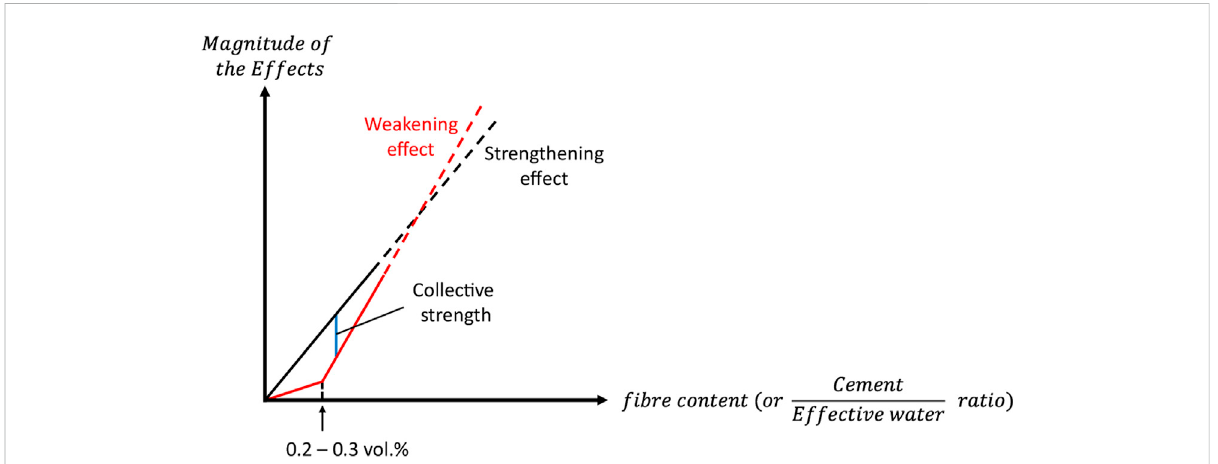
FIGURE 10 Schematic illustration for the development of the strengthening and weakening effects with the increasing fi bre content (which is inversely proportional to the effective water/cement ratio). The collective strength can be calculated by subtracting the magnitude of the weakening effect from the strengthening